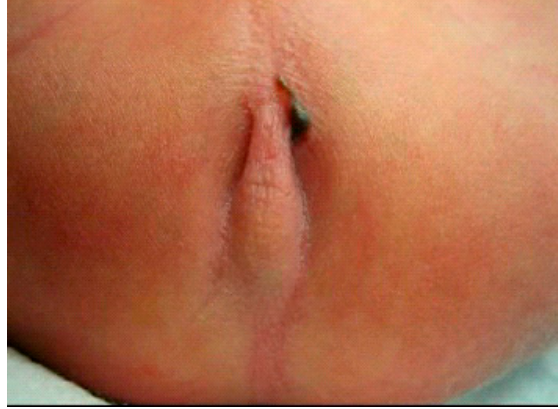
Figure 1. Screenshot of Video S1. Typical perineal fistula with bucket ‐ handle in a boy